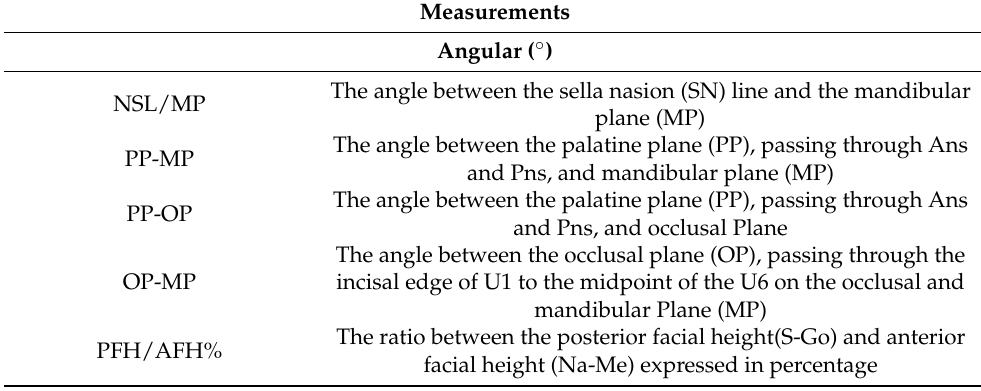
Table 1. Cephalometric measurements.